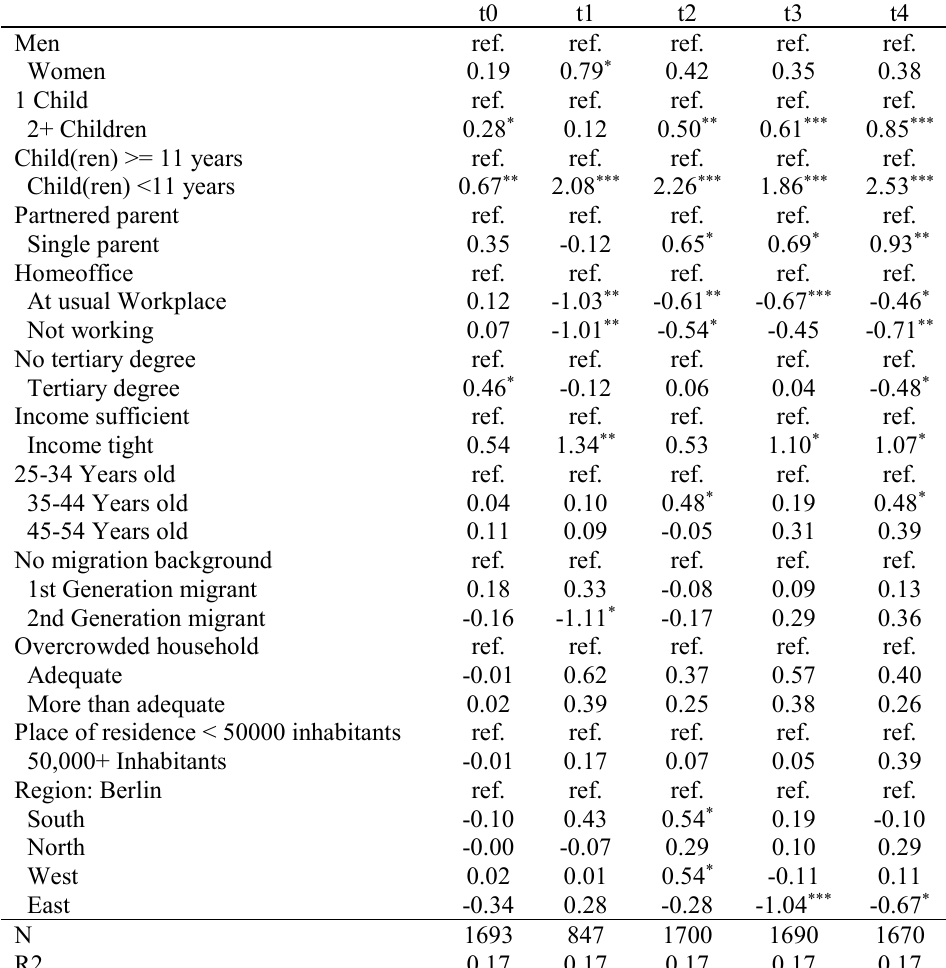
Note: The table presents marginal effects and 95% confidence intervals based on OLS regressions with clustered, robust standard errors (as shown in Table 2). The parenting stress scale ranges from 0 to 12. Higher values indicate higher levels of parenting stress. The model was fully interacted with measurement time points. The sample size at t1 is smaller than at the other time points, because the psychological distress/parenting stress questions were only integrated into the survey after its initial